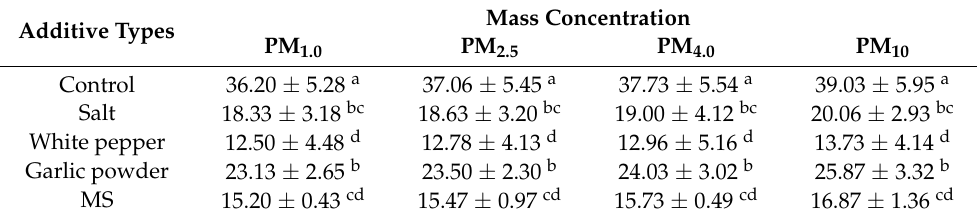
Table 3. Mass concentration and size distribution of PM 1.0 , PM 2.5 , PM 4.0 , and PM 10 emitted from the